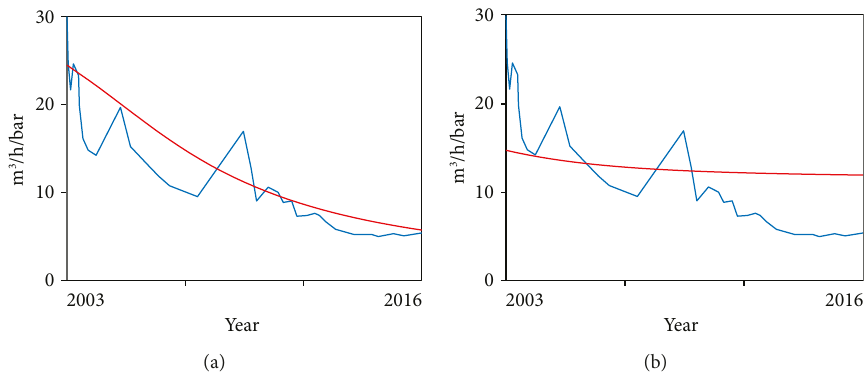
Figure 6: Observed and modeled decline curves for spatially correlated (a) and spatially uncorrelated (b) poroperm fl ow properties.